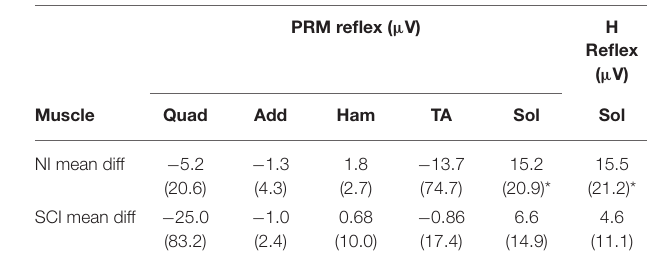
TABLE 4 | Mean (SD) difference between mid stance and mid swing